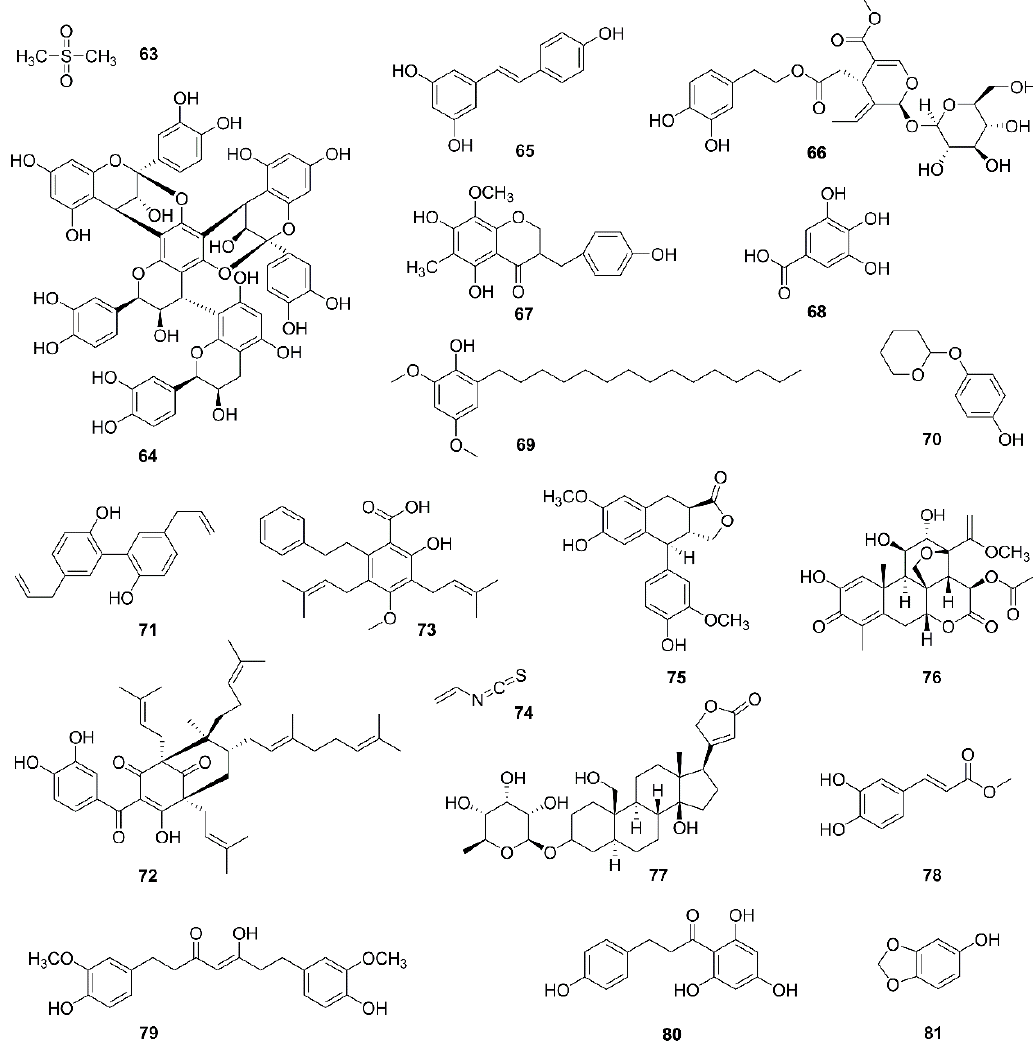
Figure 8. Chemical structures of other compounds isolated from natural products ( 63 – 81 ).